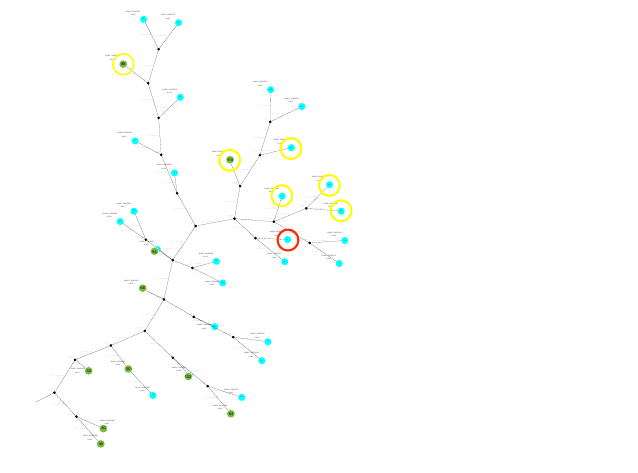
Figure 11. Simulation results. Single-line diagram of the network section where voltage violations are forecasted to occur. In yellow, nodes that violate the LVC’s limits; in red, nodes that violate the EN-50160